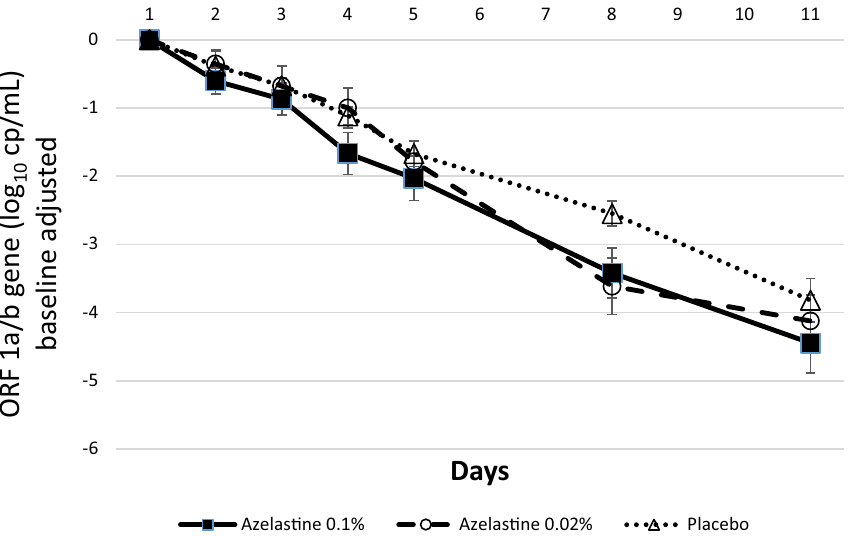
Figure 2. Absolute changes in viral copy numbers (log 10 cp/mL) from baseline (day 1) over time based on the ORF 1a/b gene (ITT analysis set).